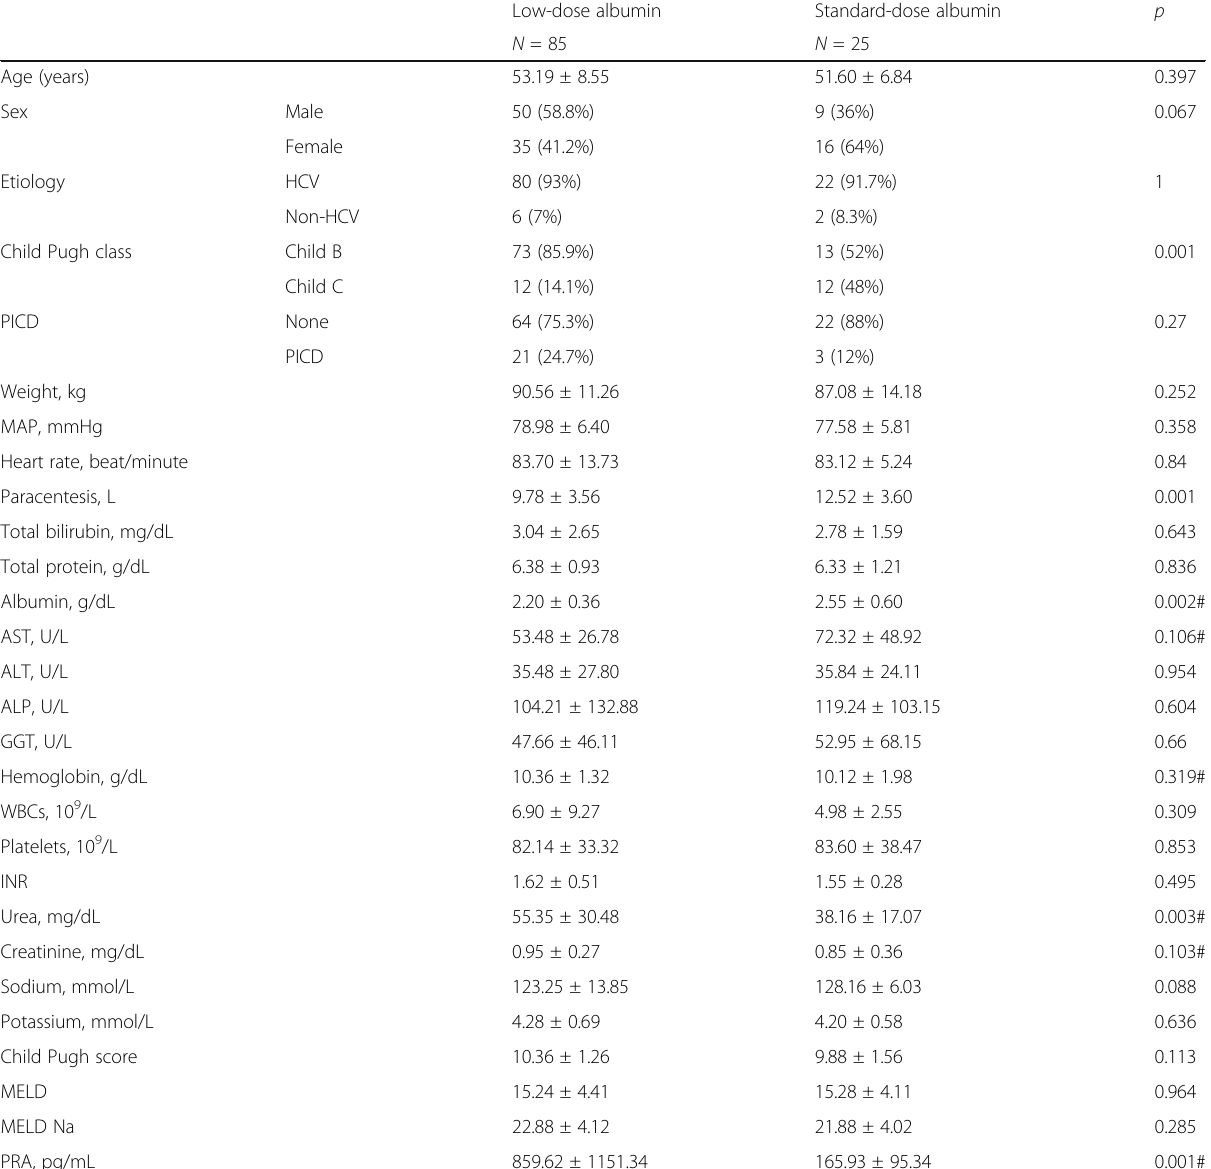
Table 1 Comparison of the baseline parameters in both groups